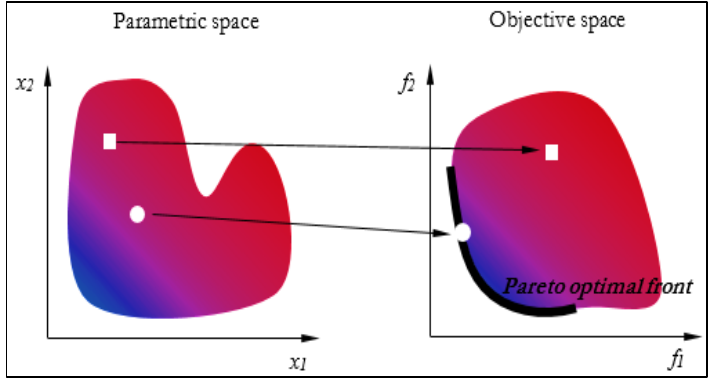
Figure 9. Objective space and search space in the multi-objective optimization problem.